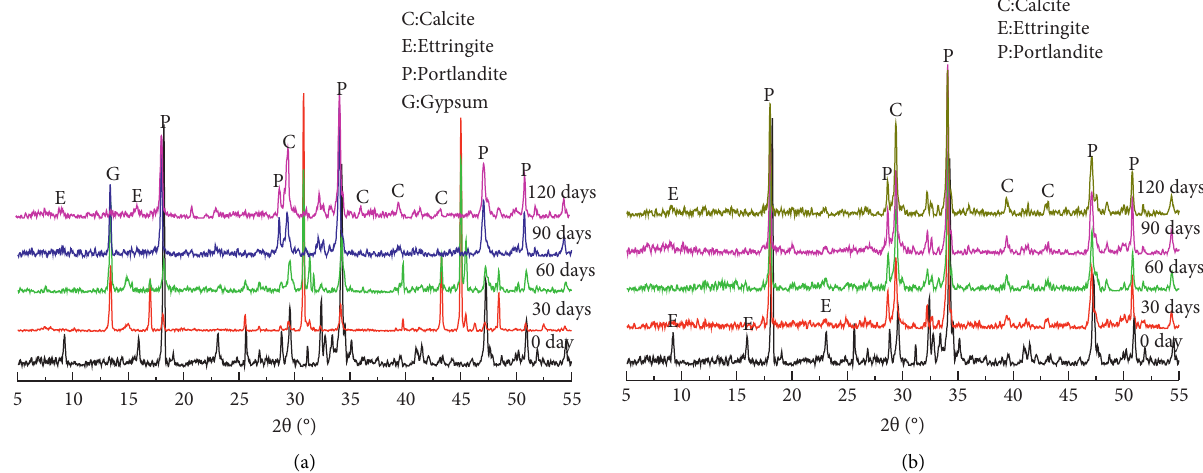
Figure 8: XRD pattern of 0% limestone powder content within 120 days. (a) Cathode surface and (b) anode